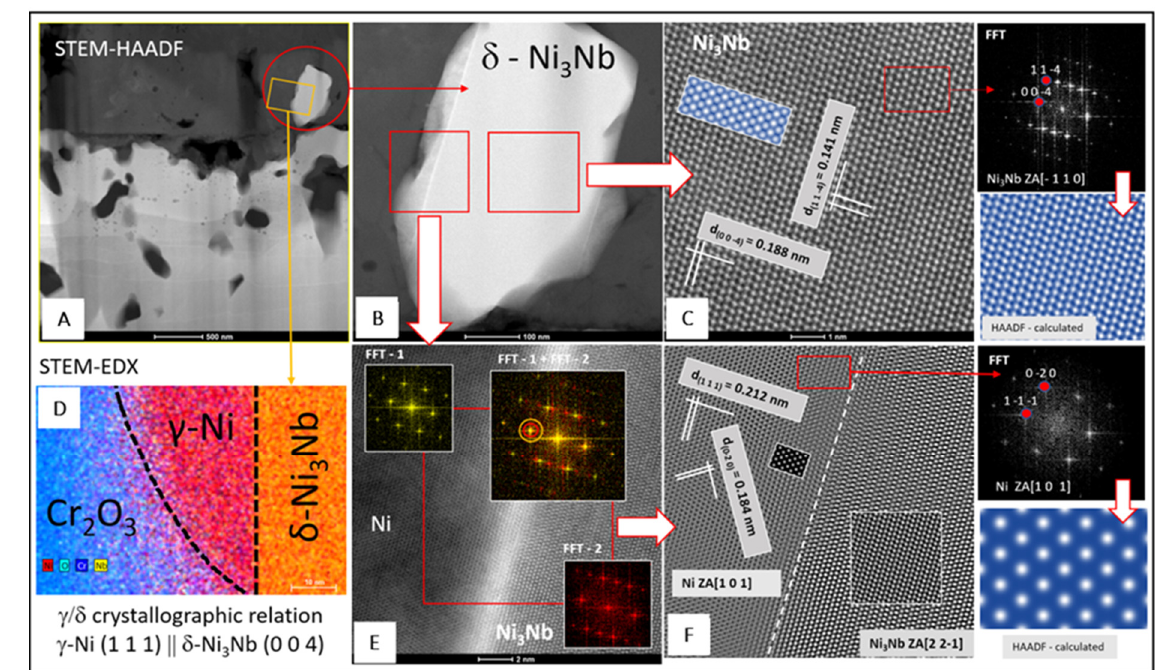
Figure 8. High-resolution analysis of δ phase observed in the scale layer formed on the 718Plus superalloy after oxidation at 850 °C for 120 h in wet air: ( A ) STEM-HAADF image of the scale and beneath highlighting the presence of δ -Ni 3 Nb particle particles in this area Figure ( B ), ( C ) HRSTEM-HAADF image of δ phase particle with FFT image and HAADF image simulated using JEMS software, ( D ) superimposed STEM-EDX maps of selected elements, ( E ) FFT analysis of selected areas of HRSTEM-HAADF image, and ( F ) HRSTEM-HAADF image after filtering using an FFT showing the δ -Ni 3 Nb/ γ interface.